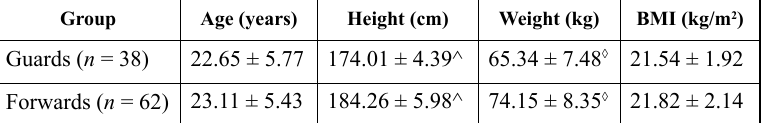
Figure 1. Posterolateral reach using the